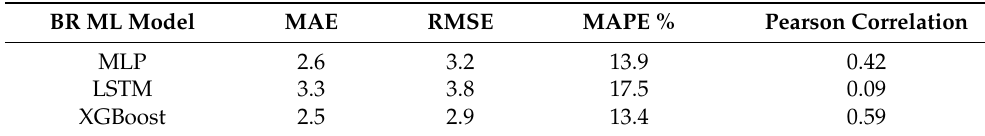
Table 5. Testing Performance Results of the BR ML Models.